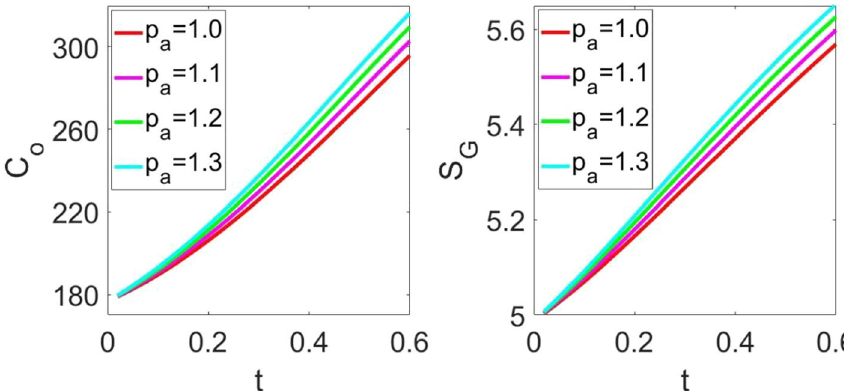
Fig. 17 Variations in the a coherence and b Gibbs entropy as functions of the time variable. The parameters are taken as: α = 1, V = 0